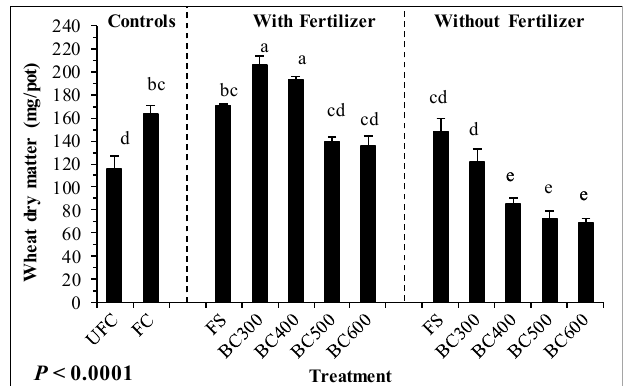
Figure 1. Response of total biomass yield of wheat grown for 5 weeks to application with and without a fertilizer of 8 t ha − 1 of four date palm residue biochars (BCs) that were produced with different pyrolysis temperatures (BC300, BC400, BC500, and BC600) and the BC feedstock (FS). Treatments also included an unfertilized control (UFC) and a fertilized control (FC). Bars sharing the same letter among treatments are not significantly di ff erent according to the Student–Newman–Keuls (SNK) test ( p ≤ 0.05). Errors bars represent the standard error of the mean ( n = 4).